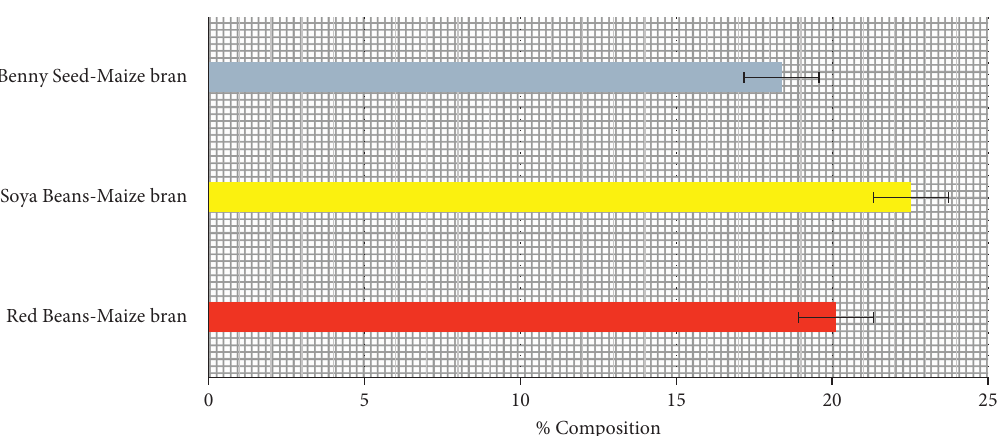
Figure 5: Percentage unrefined protein content of